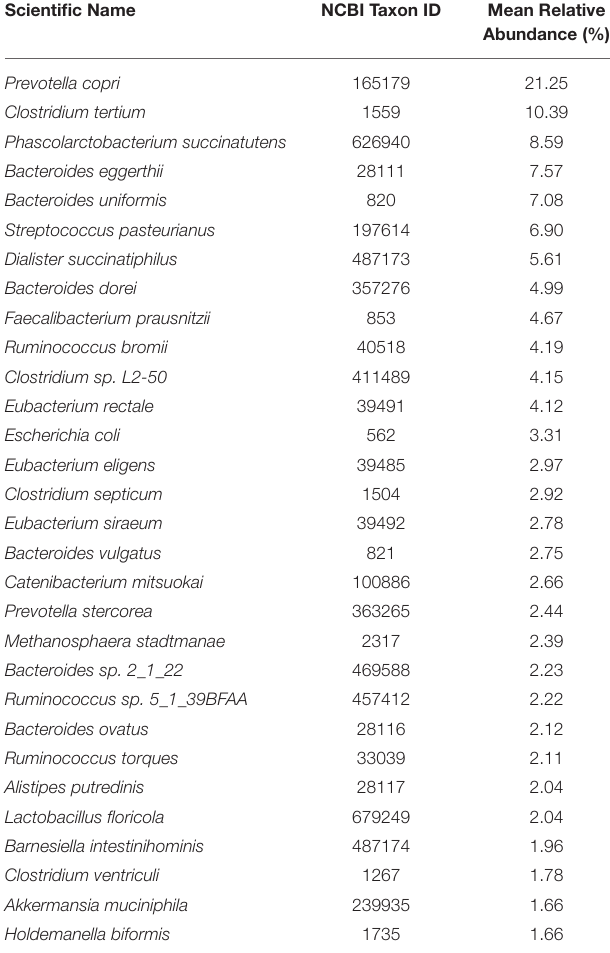
TABLE 1 | Ranking of top 30 intestinal microbiota with T1D